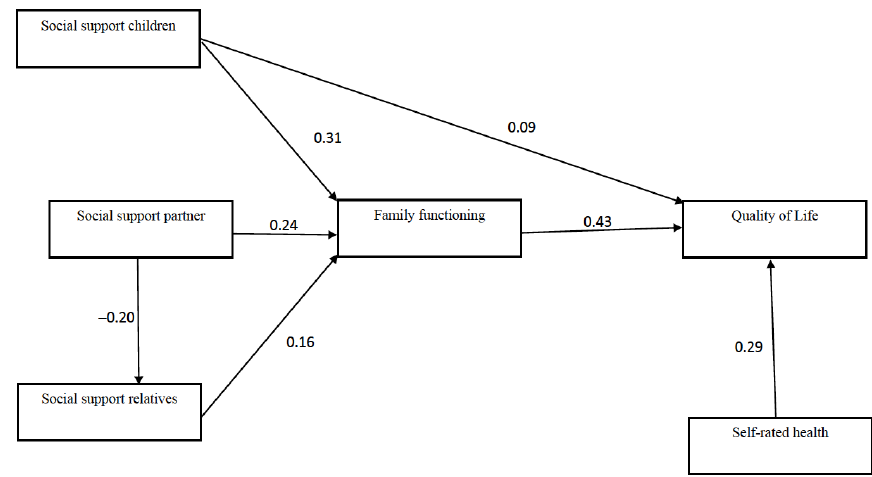
Figure 3. Multi-group analysis (men and women). Standardized